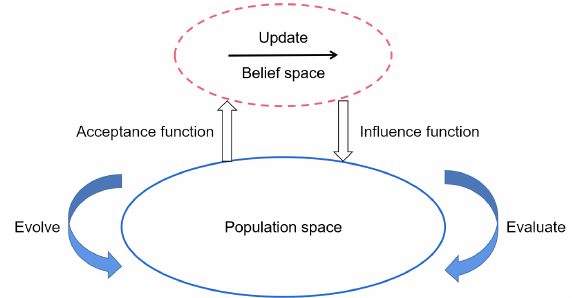
Figure 1. Framework of the cultural algorithm